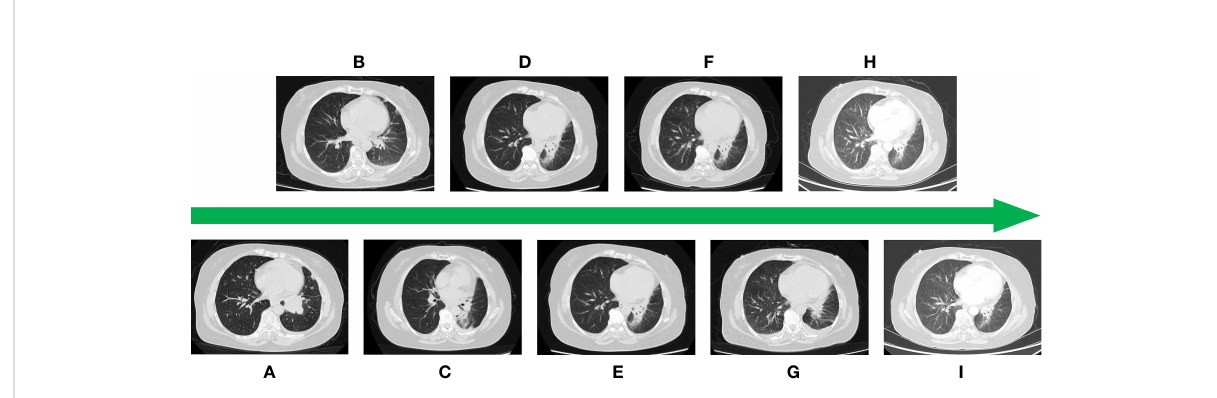
FIGURE 1 (A) CT image at the time of initial diagnosis. (B) Image after fi rst-line treatment. (C) Image after second-line treatment. (D) Image after third-line treatment. (E) Image after fourth-line treatment. (F) Image after fi fth-line treatment. (G) Image after sixth-line treatment. (H) Image after seventh-line treatment. (I) Image after eighth-line treatment.